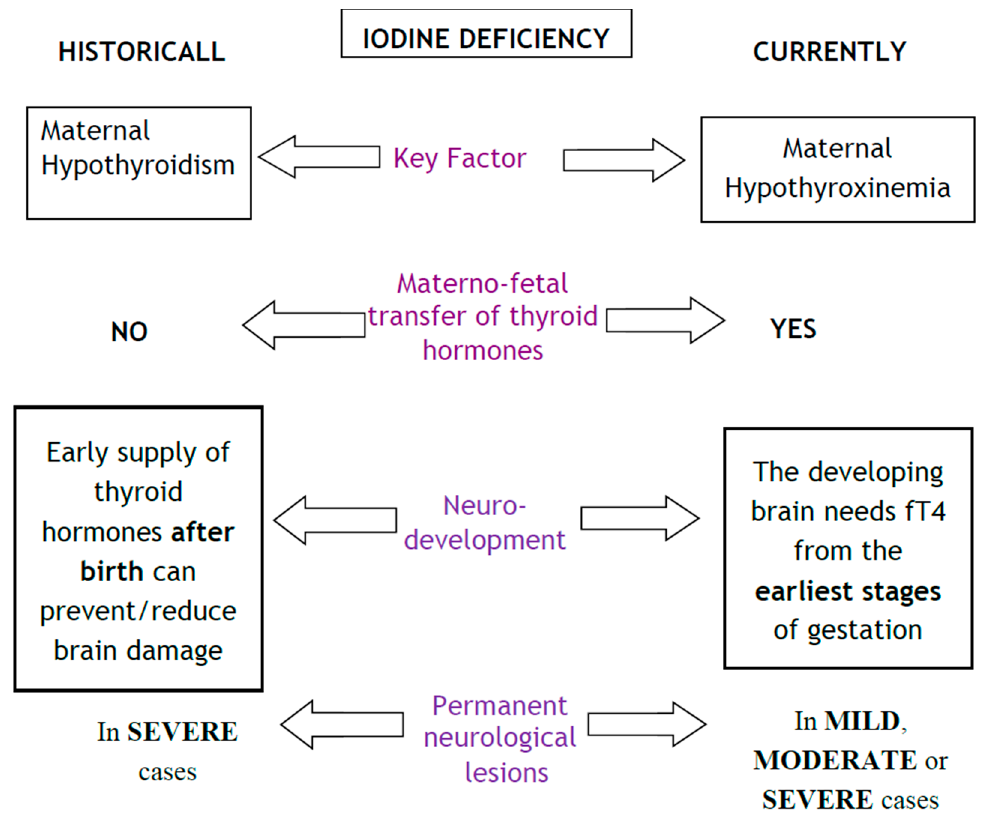
Figure 1. Foetal and neonatal effects of iodine deficiency during pregnancy. The main advance has been that maternal hormone transfer to the foetus during pregnancy is definitely accepted, as well as the existence of damage in the progeny even in the absence of maternal hypothyroidism.